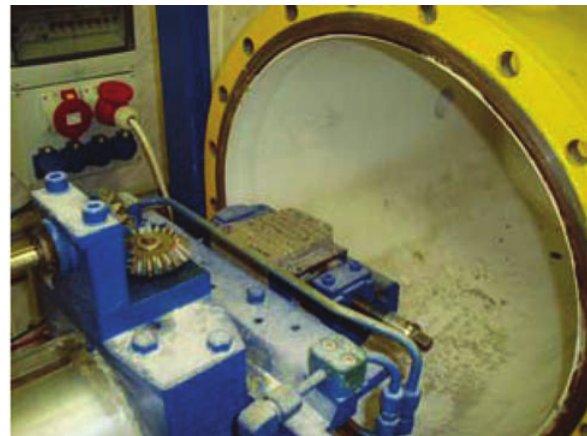
Fig. 1. Support with a sample in front of the pressure